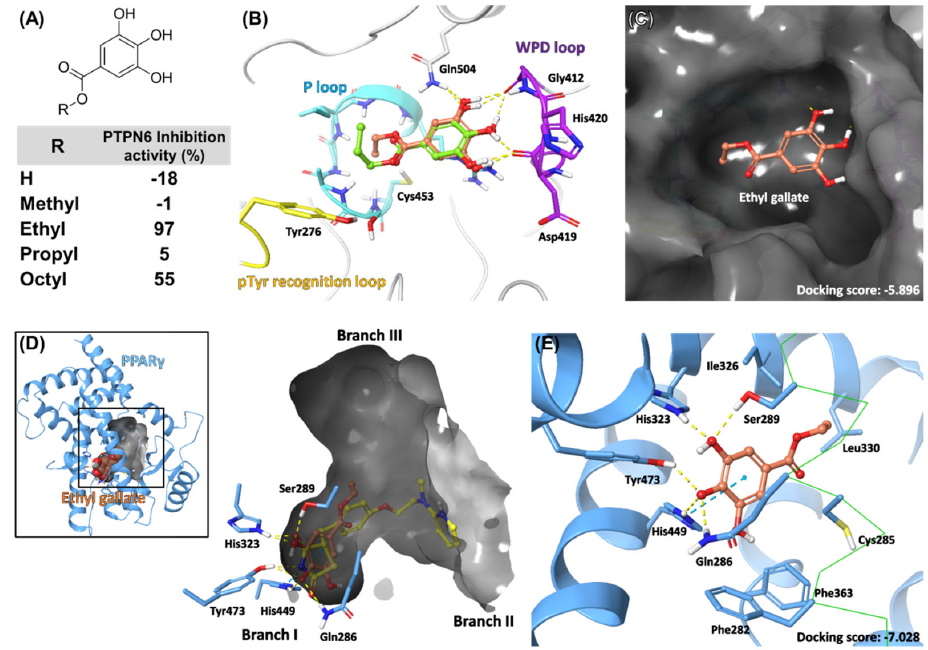
Figure 5. Docking model of ethyl gallate (EG) on PTPN6 and PPAR γ . ( A ) Structure of gallate derivatives and screening results of gallate derivatives on PTPN6. ( B ) Docking model of EG (orange) and propyl gallate (pale green) on PTPN6 (white). Ligands are presented as ball-and-stick models. Important motifs and residues of PTPN6 are highlighted in color. Hydrogen bonds are represented as yellow dashed lines. ( C ) Surface representation of PTPN6 in gray. ( D ) Docking model of EG (orange) and the X-ray conformation of rosiglitazone (yellow) on PPAR γ (sky blue). The orthosteric pocket is represented as a gray surface. ( E ) Multiple H-bonds between EG and residues in branch I. π – π stacking interaction is represented as blue dashed lines. For visual inspection, the representation of helix3 is simplified as a green CA trace line.